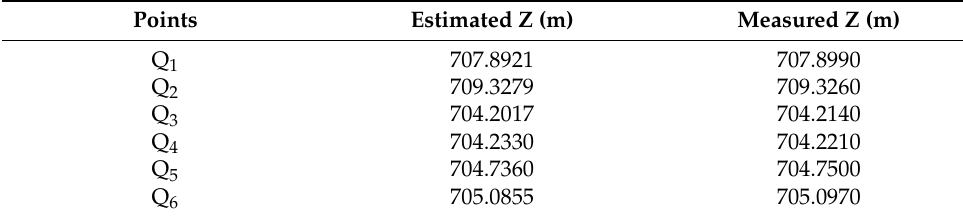
Table 3. The estimated and the measured z-coordinates of the Q